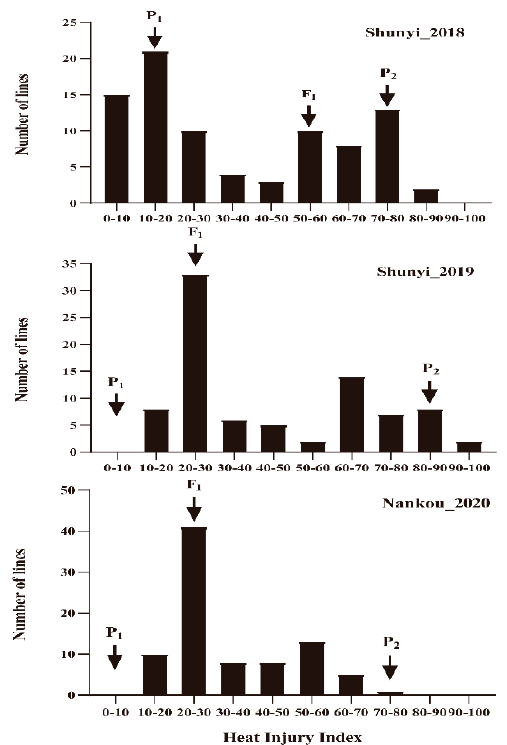
Figure 3. Frequency distribution of heat injury index in RIL populations in 2018, 2019, and 2020. X -axis indicates the heat injury index (HII); Y -axis indicates the number of individuals in each HII category. P 1 : parental line “99281” (heat-tolerant) and P 2 : parental line “931” (heat-sensitive). Arrows indicate the average HII of parental and F 1 lines.